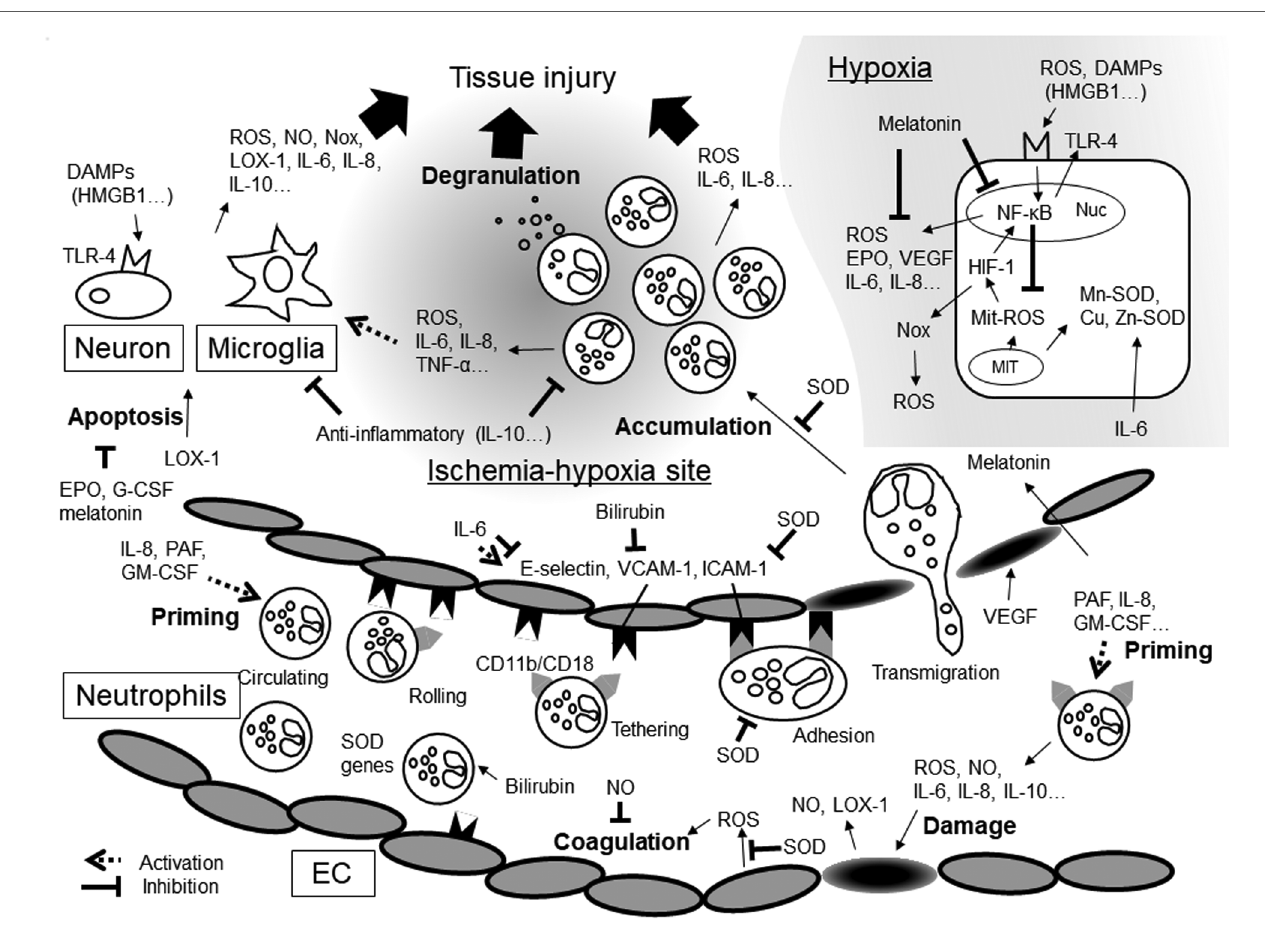
FIGURE 1 In fl ammatory mediators and oxidative stresses in hypoxic-ischemia. DAMPs, damage-associated molecular patterns; EC, endothelial cells; EPO, erythropoietin; G-CSF, granulocyte-macrophage colony stimulating factor; GM-CSF, granulocyte-macrophage colony stimulating factor; HIF-1, hypoxia- inducible factors-1; HMGB1, high- mobility group box 1; ICAM-1, intercellular adhesion molecule; IL, interleukin; LOX-1, lectin-like oxidized low-density lipoprotein receptor-1; MIT, mitochondria; NF- κ B, Nuclear factor-kappa B; NO, nitric oxide; Nox, NADPH oxidase; Nuc, nuclear cell; PAF, platelet- activating factor; ROS, reactive oxygen species; SOD, superoxide dismutase; TLR-4, Toll-like receptors-4; TNF- α , tumor necrosis factor- α ; VCAM-1, vascular cell adhesion molecule; VEGF, vascular endothelial growth